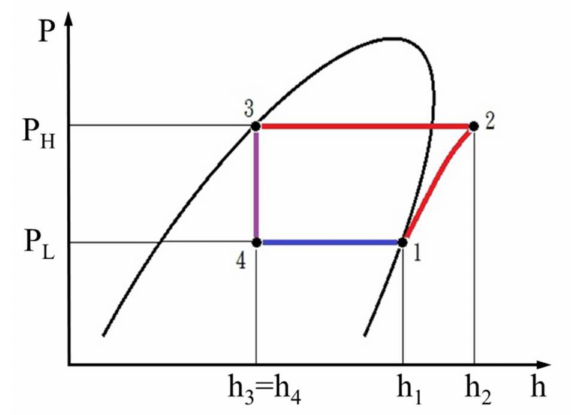
Figure 4. Mollier Chart of the ideal refrigeration